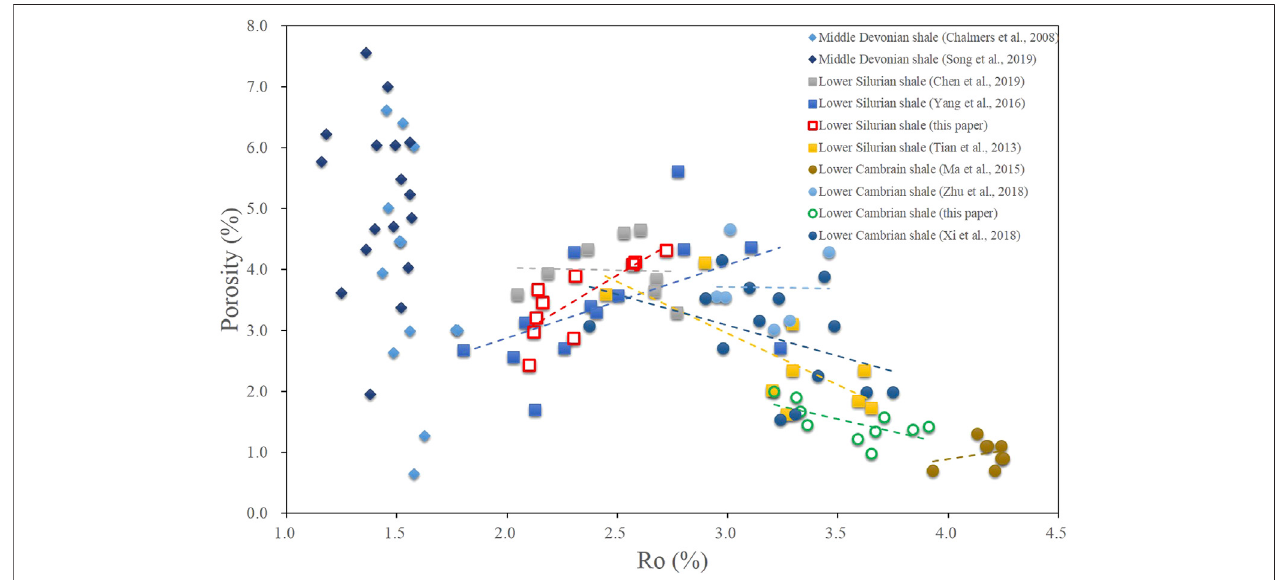
FIGURE 12 | Porosity distribution of marine shales in a wide range of thermal maturities; data collected from previous research and this paper.